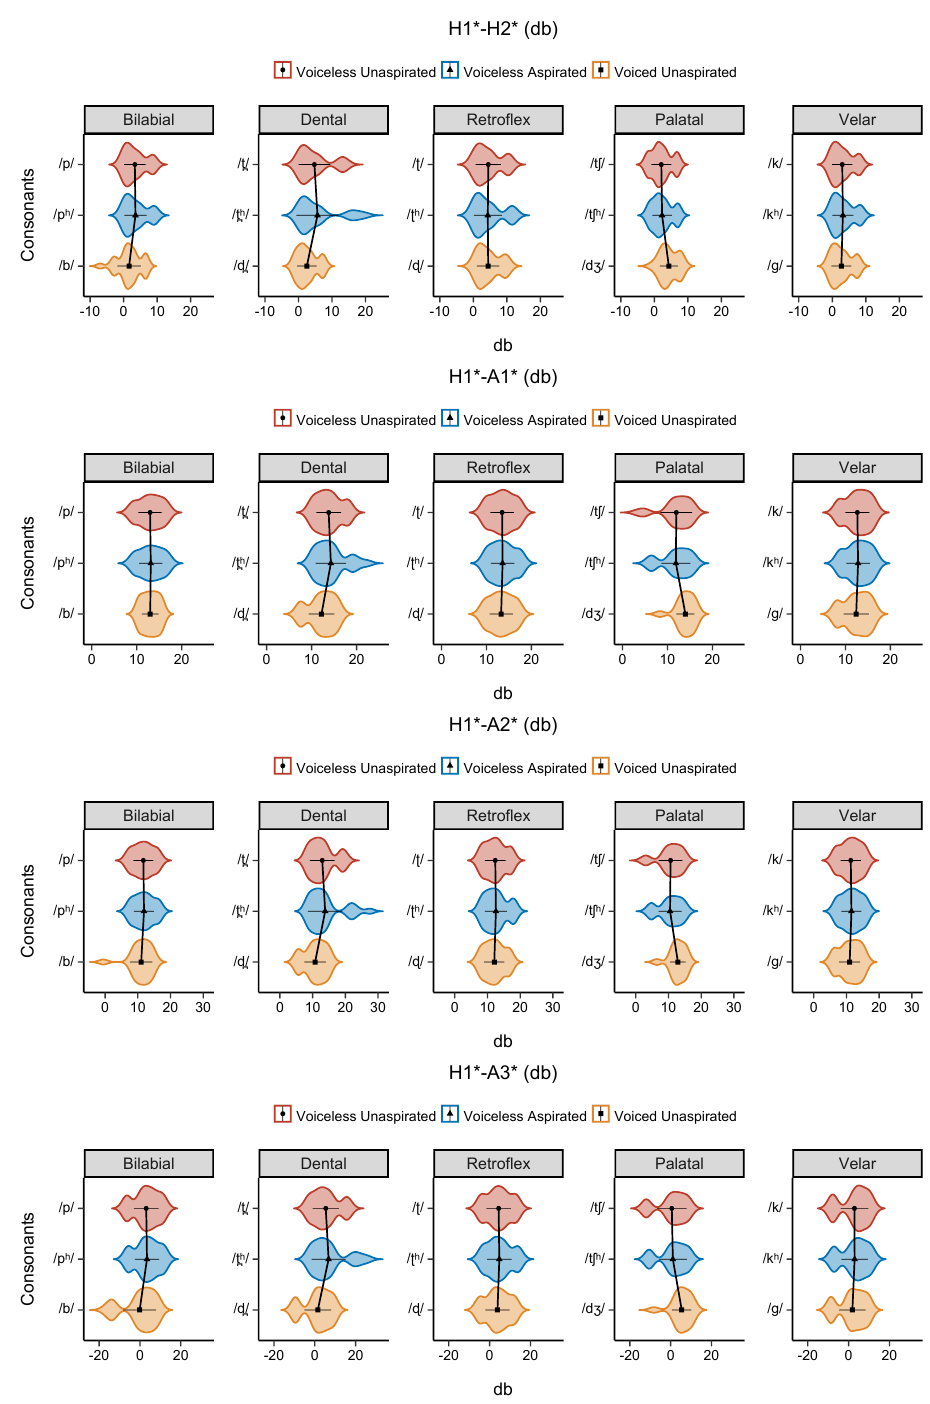
Figure 4. Violin plots of H1*-H2*, H1*-A1* H1*-A2*, and H1*-A3*. Black lines connect the means of the three laryngeal categories (voiceless unaspirated, voiceless aspirated, and voiced unaspirated) at each place of articulation (bilabial, dental, retroflex, palatal, and velar). H1*-A2* onsets differentiated the voiced unaspirated vs. voiceless aspirated stops ( p = 0.001) and voiced unaspirated vs. voiceless unaspirated stops ( p < 0.001). Bilabials vs. palatals ( p = 0.045), bilabials vs. retroflexes ( p < 0.001), and bilabials vs. velars ( p < 0.001) showed significant differences in H1*-A2*. The voiceless aspirated stops exhibited the highest H1*-A2* onsets, followed by voiceless unaspirated and voiced unaspirated stops (voiceless aspirated > voiceless unaspirated > voiced